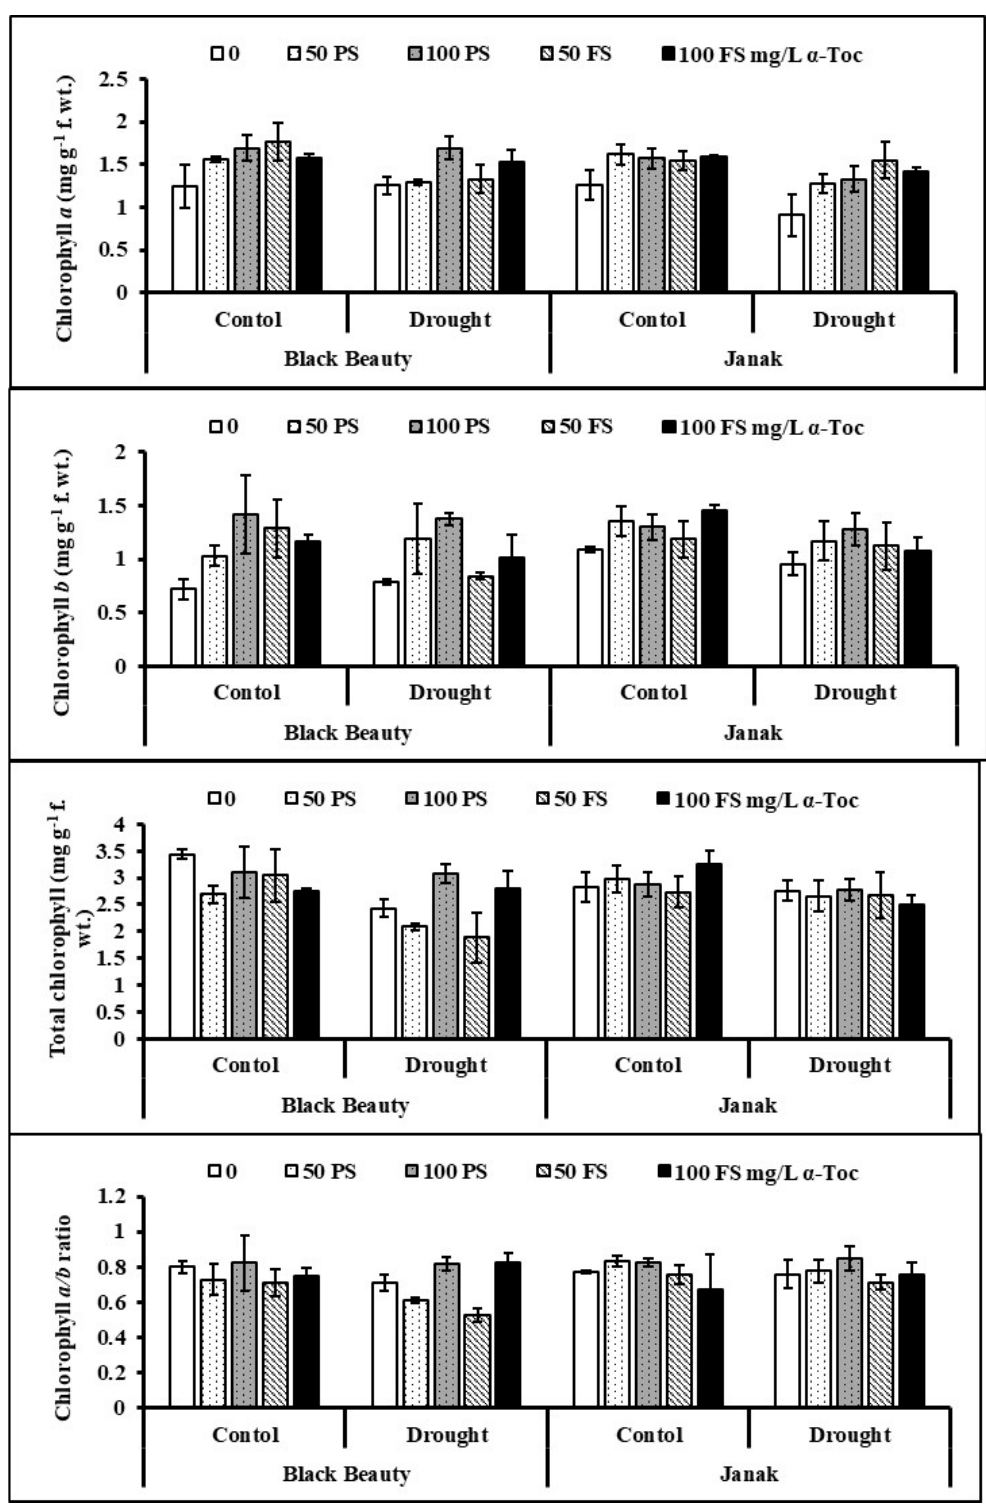
Figure 2. Leaf chlorophyll content in two eggplant cultivars subjected to exogenous (pre-sowing (PS) and foliar spray (FS)) under varying water regimes (mean ± S.E.; n = 4).